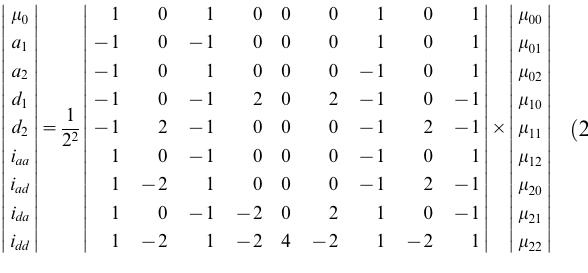
Adding a locus, C with two alleles C and c , to the two-gene model generates 27 three-locus genotypes, expressed as j 1 j 2 j 3 ( j 3 ~ 2,1,0 for genotypes CC , Cc , and cc , respectively). A three-